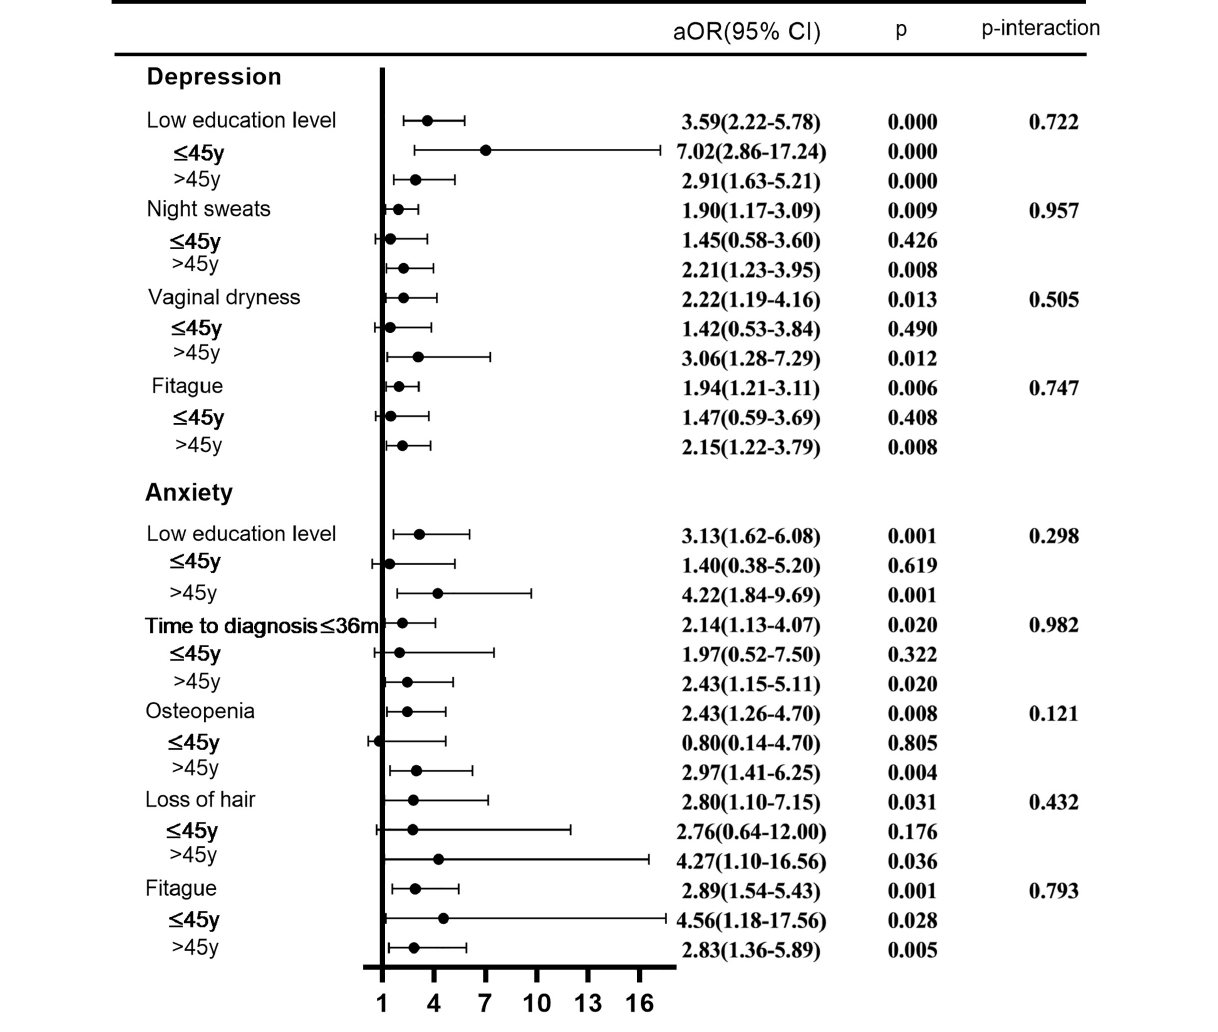
FIGURE 1 | Multivariate analysis of depression and